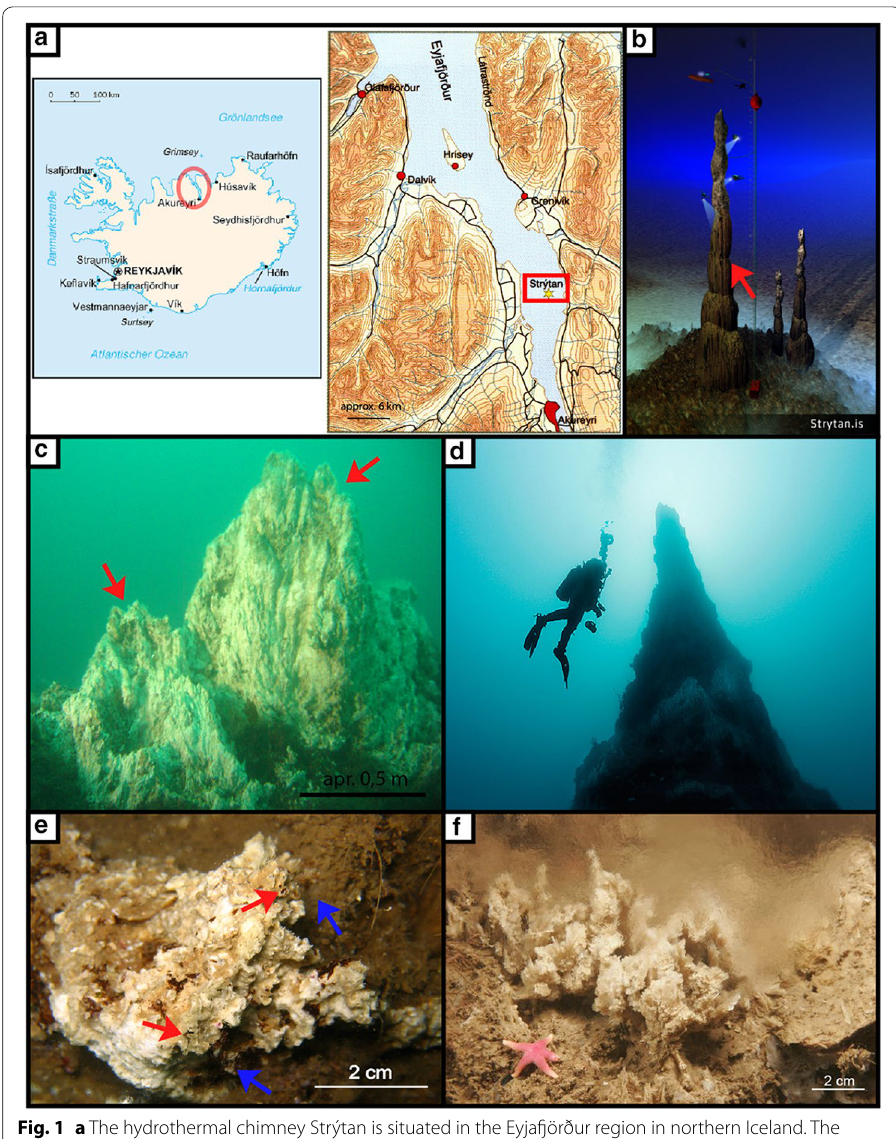
Fig. 1 a The hydrothermal chimney Strýtan is situated in the Eyjafjörður region in northern Iceland. The diving locality lies in the fjord north of Akureyri at a water depth of 15–60 m. Map of Iceland modified after de.wikipedia.org; map of Strýtan modified after strytan.is/E. Bogason. b Schematic sketch of the three geo- thermal cones at Strýtan. Red arrow marks the approximate situation of the sampling point (image: strytan. is). c Top of the largest hydrothermal chimney with water emanations ( arrows ). Due to ongoing mineral precipitation, the cones are still growing. d Diver at the largest hydrothermal chimney at Strýtan. The cone rises approximately 45 m from the seafloor. Photography by E. Bogason. e Submarine water escape structure at Strýtan. Red arrows mark the small-scale tubes. Blue arrows indicate areas of diffuse venting (c.f. f ). f Active, recent water escape structure. The large amount of water released and the resulting fibrillation of the water column obliterate the sedimentary pattern, although it is clearly visible in reality (c.f. e ; photography by E.